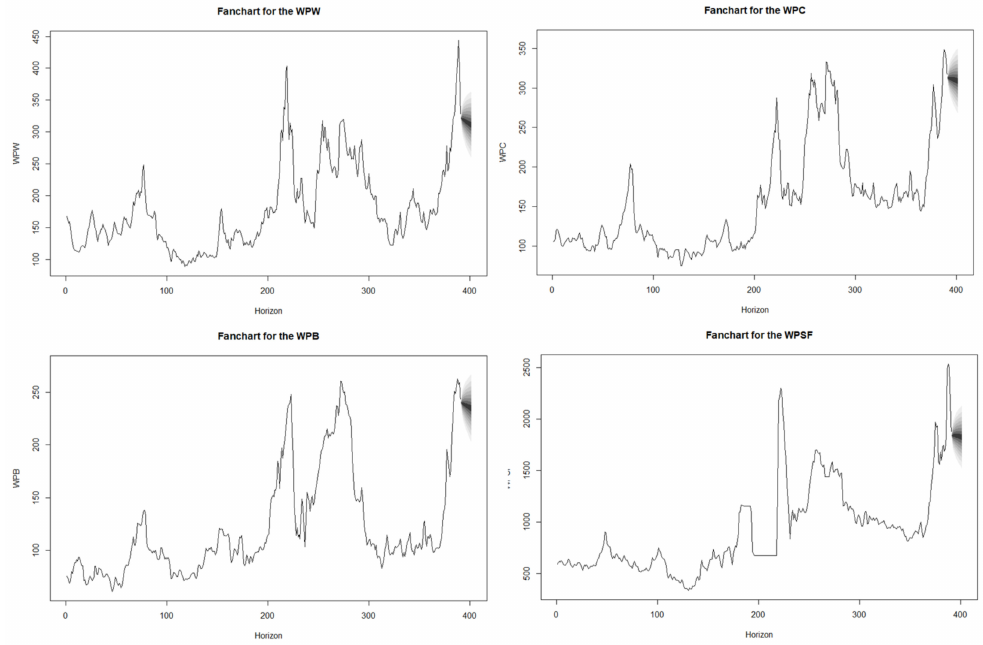
Figure 4. Estimated forecasts with the VAR fanchart for ten periods ahead. Note: Plots indicate predictions with raw data through the VAR fanchart package. The estimated forecasts were conducted individually for each variable with a 95% confidence band for ten months ahead. The results cover the entire period from 1 January 1990 to 1 June 2022, based on 391 observations. The estimated forecasts start on 1 July 2022, and end on 1 April 2023. The black line represents the predictions, and the gray-shaded area indicates the error